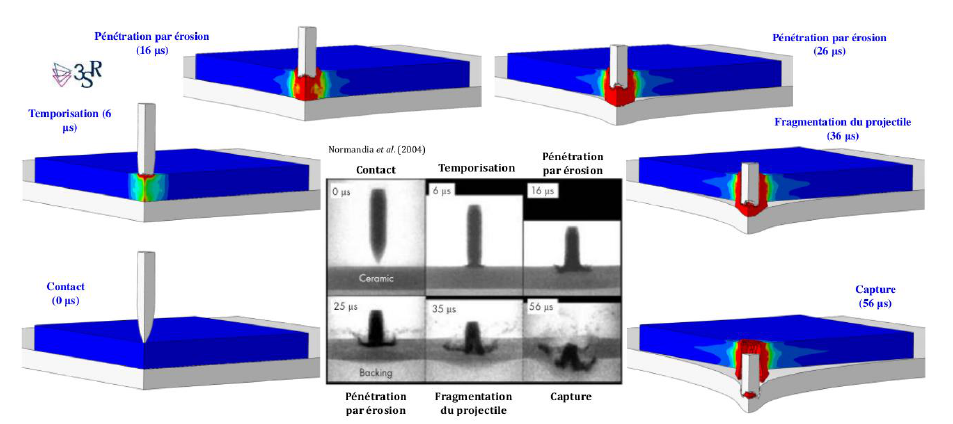
Figure 1: Evolution of the damage in the impact area during a ballistic impact [15].